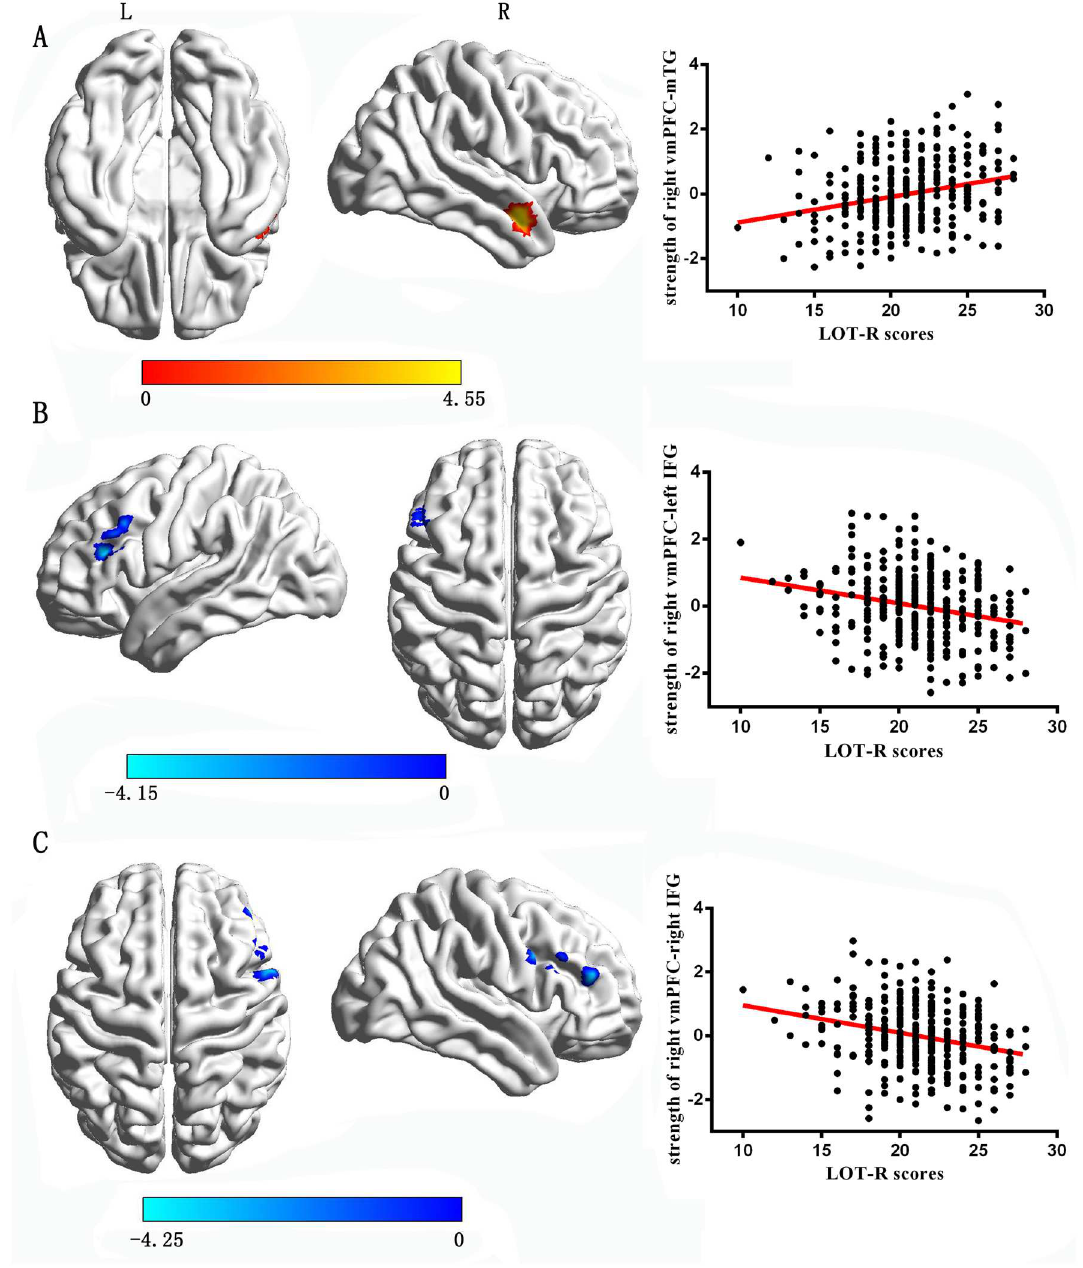
Fig 2. The correlations between optimism and the RSFC with the right vmPFC (with global signal regression). A: The regions and partial correlations scatterplot of positive associationof optimism and the strength of RSFC betweenthe right vmPFC and mTG. B: The regionsand partial correlationsscatterplot of negativeassociationof optimism and the strength of RSFC betweenthe right vmPFC and left IFG. C: The regions and partial correlationsscatterplot of negative associationof optimism and the strength of RSFC betweenthe right vmPFC and right